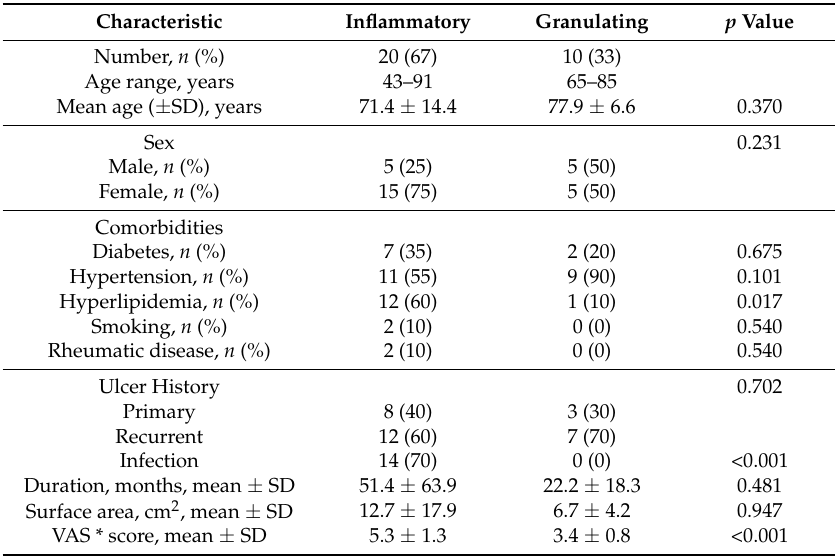
Table 1. Demographic and clinical characteristics.